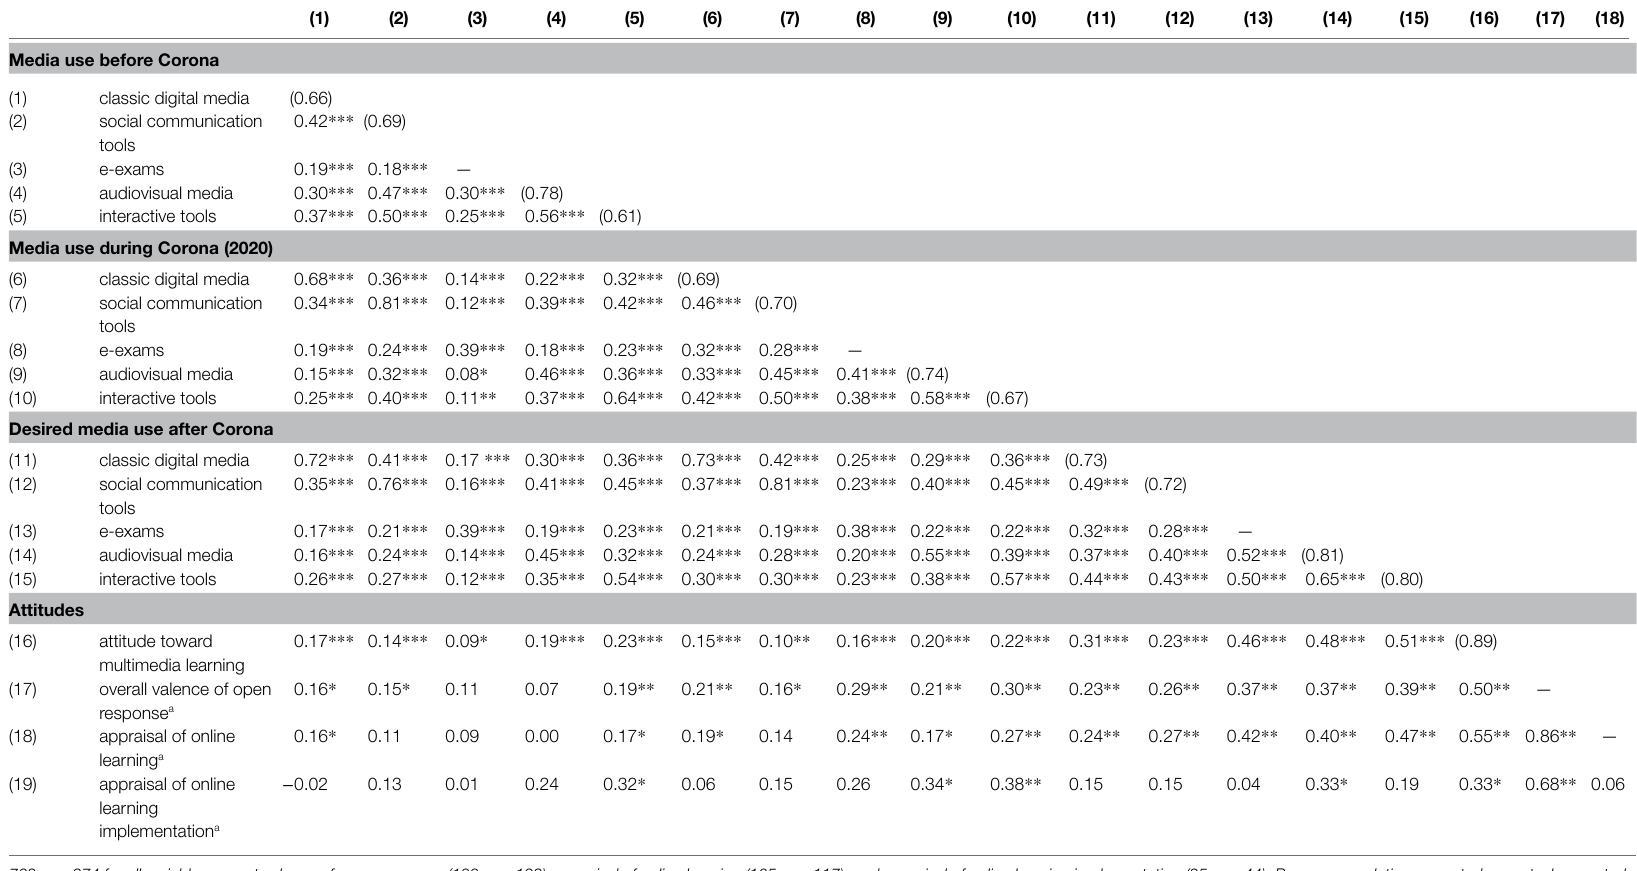
TABLE 1 | Correlations between attitude toward multimedia learning and intensity of media